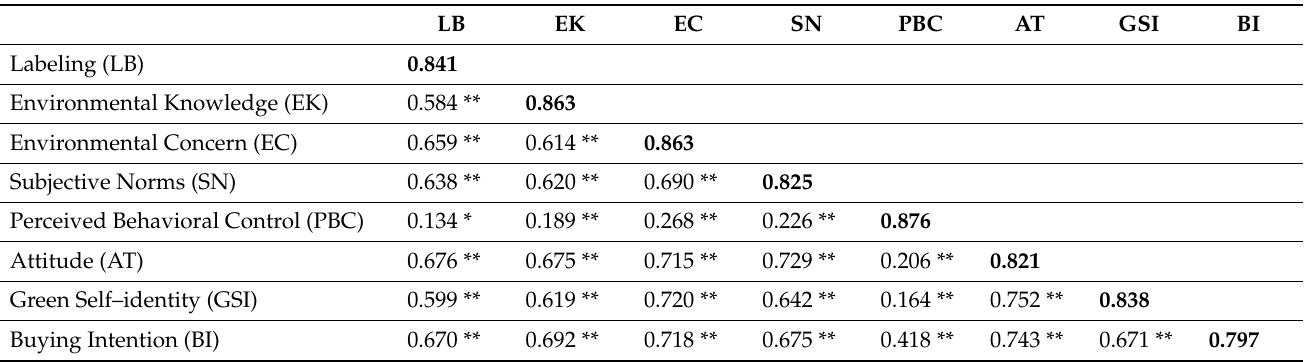
Table 4. Discriminant Validity (Fornel Larker